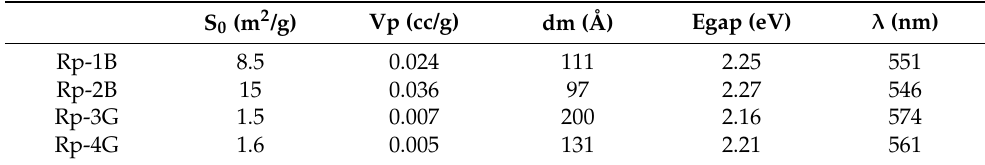
Table 1. Values of S 0 , Vp, dm, Egap and λ of the samples.